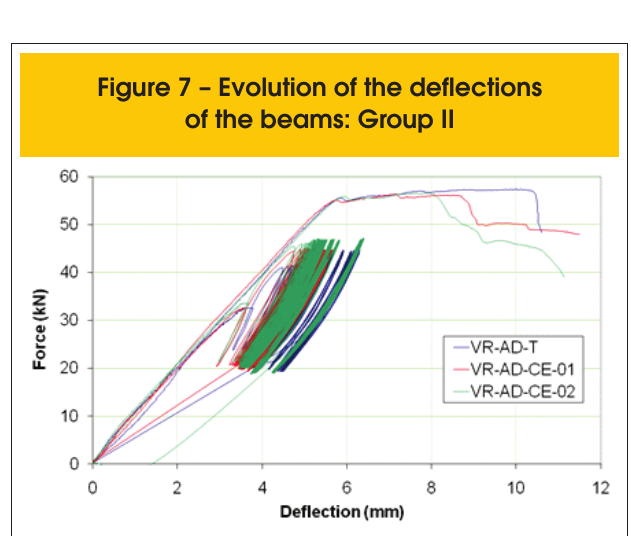
Figure 7 – Evolution of the deflections of the beams: Group